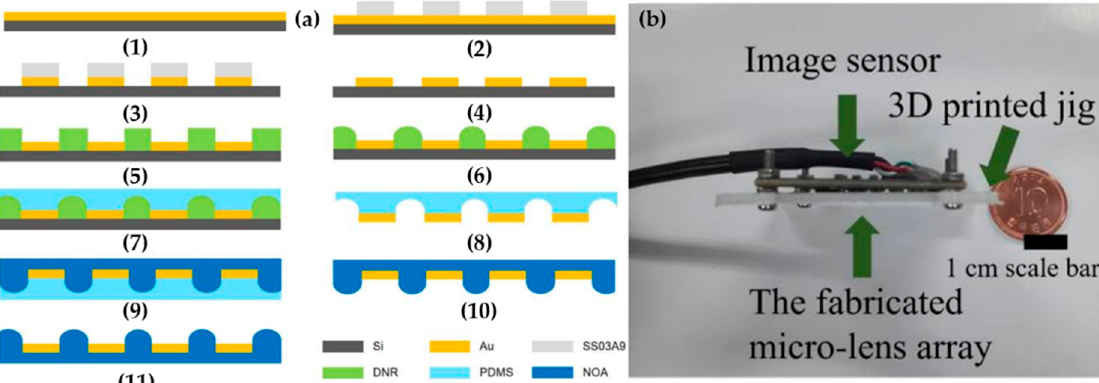
Figure 8. ( a ) The fabrication process of the microlens using the soft lithography process. ( b ) The structure of artificial compound eye system. Reproduced from [5]. CC by 4.0.